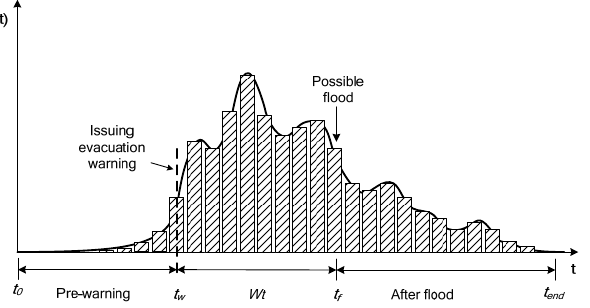
Fig. 7. Flood consequences as functions of time for evacuating the PAR